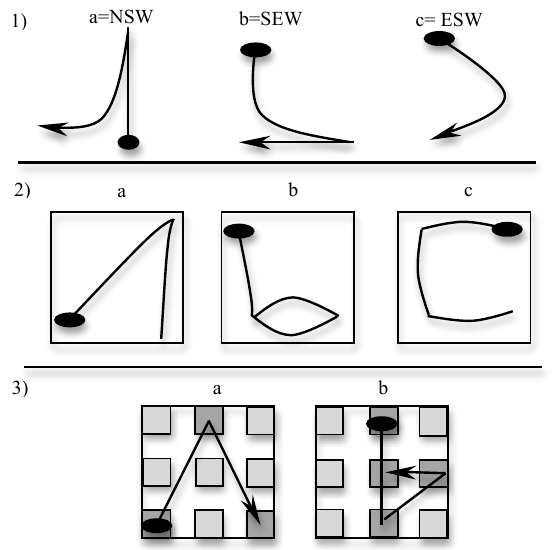
Figure 2: 1) Adapted from MDITIM gaze gestures (P. Isokoski, 2000). 2) Adapted from the eyewrite system (Wobbrock et al., 2008) 3) Adapted